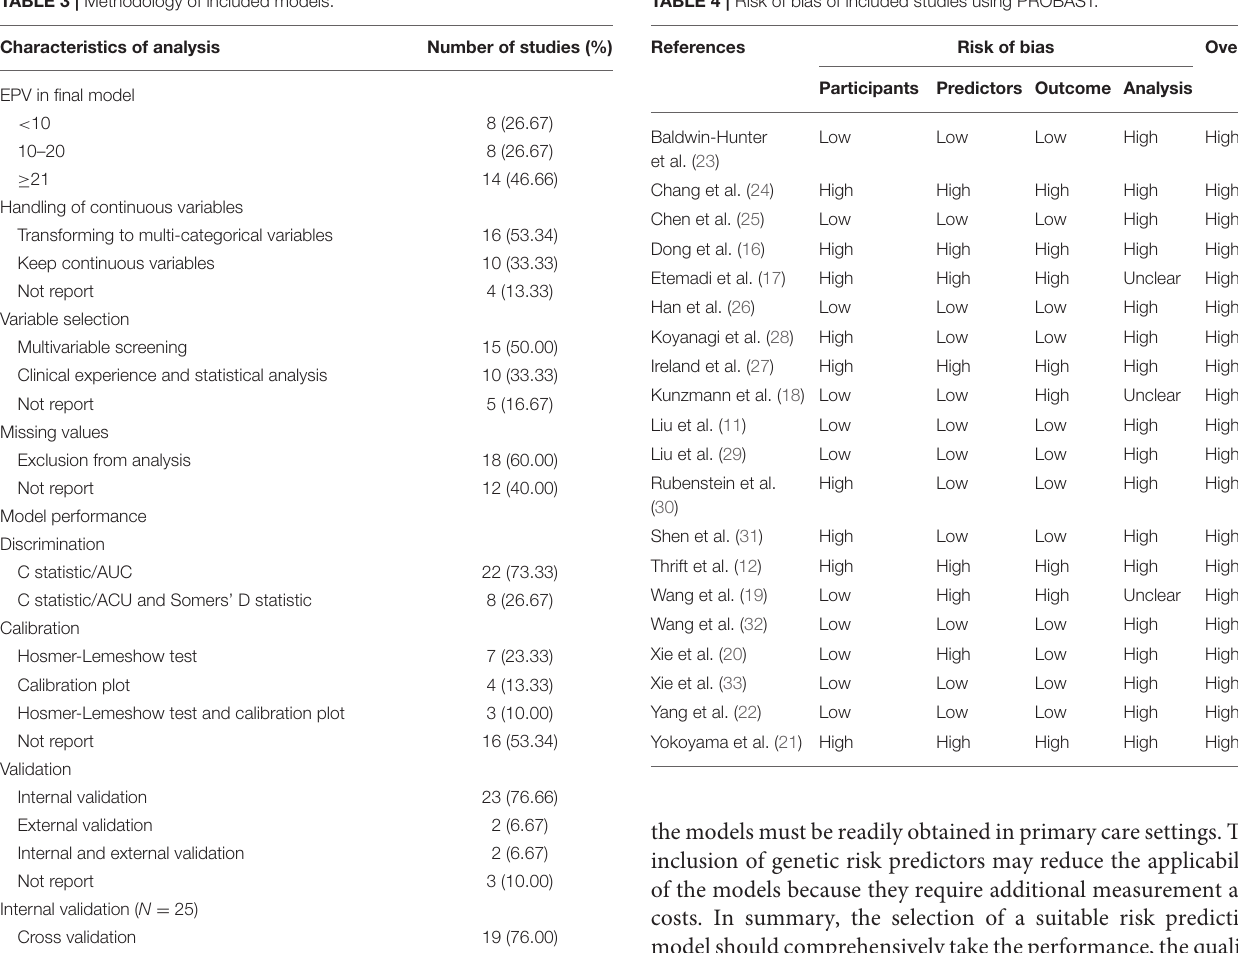
TABLE 3 | Methodology of included models. TABLE 4 | Risk of bias of included studies using